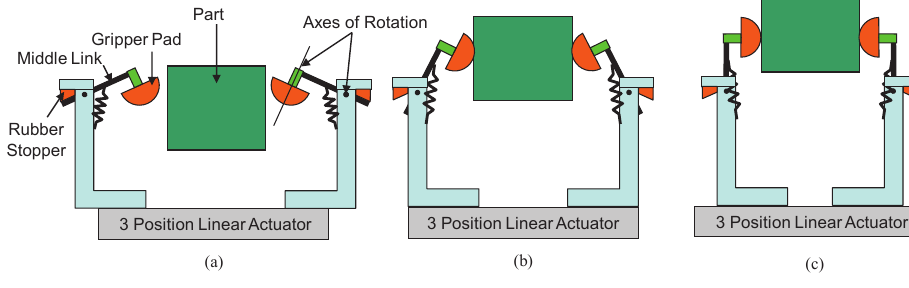
Figure 1. Parallel jaw gripper with singularities.